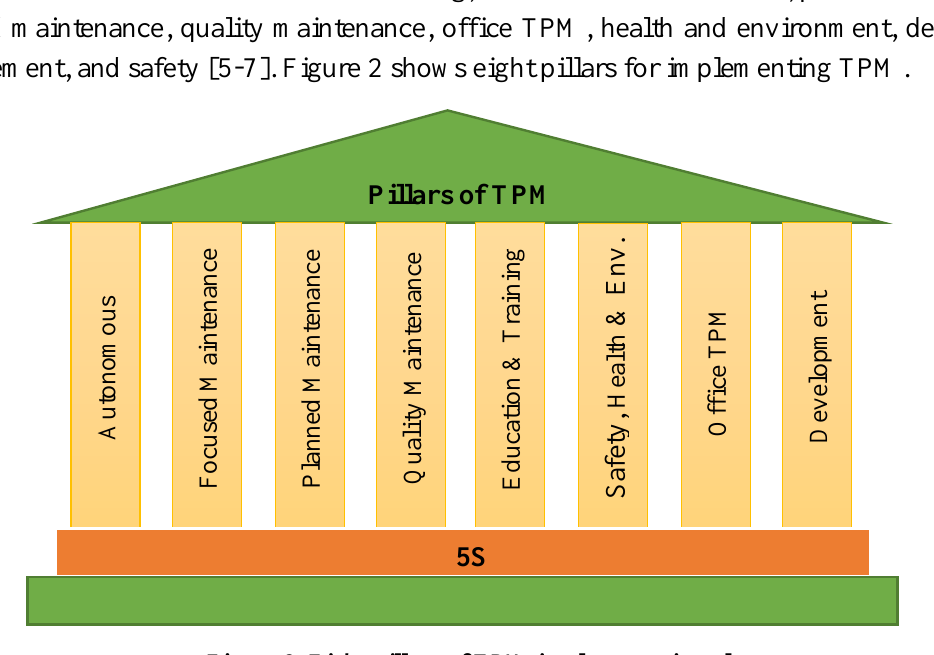
Figure 2. Eight pillars of TPM implementation